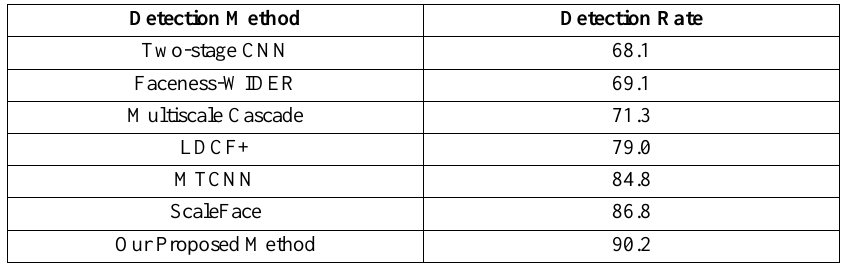
Table 1. The Comparison of Face detection accuracy with some other methods for the WIDER FACE